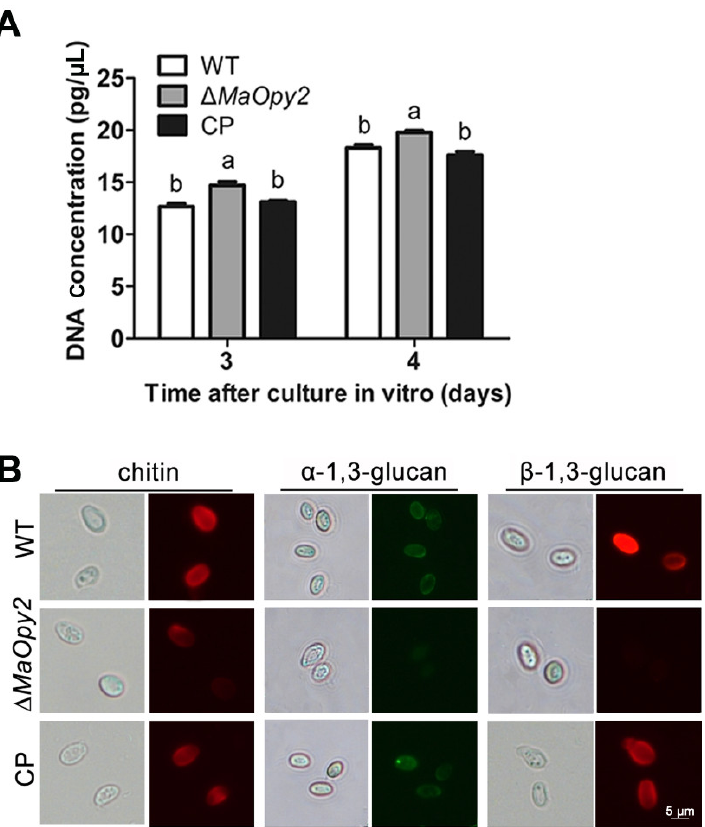
Figure 7. Detection of fungal growth and conidial cell surface components. ( A ) Concentration of fungal gDNA in host hemolymph without blood cells in vitro. ( B ) Detection of conidial cell surface components with labeled lectins and antibodies. a & b presented the significant difference at p <